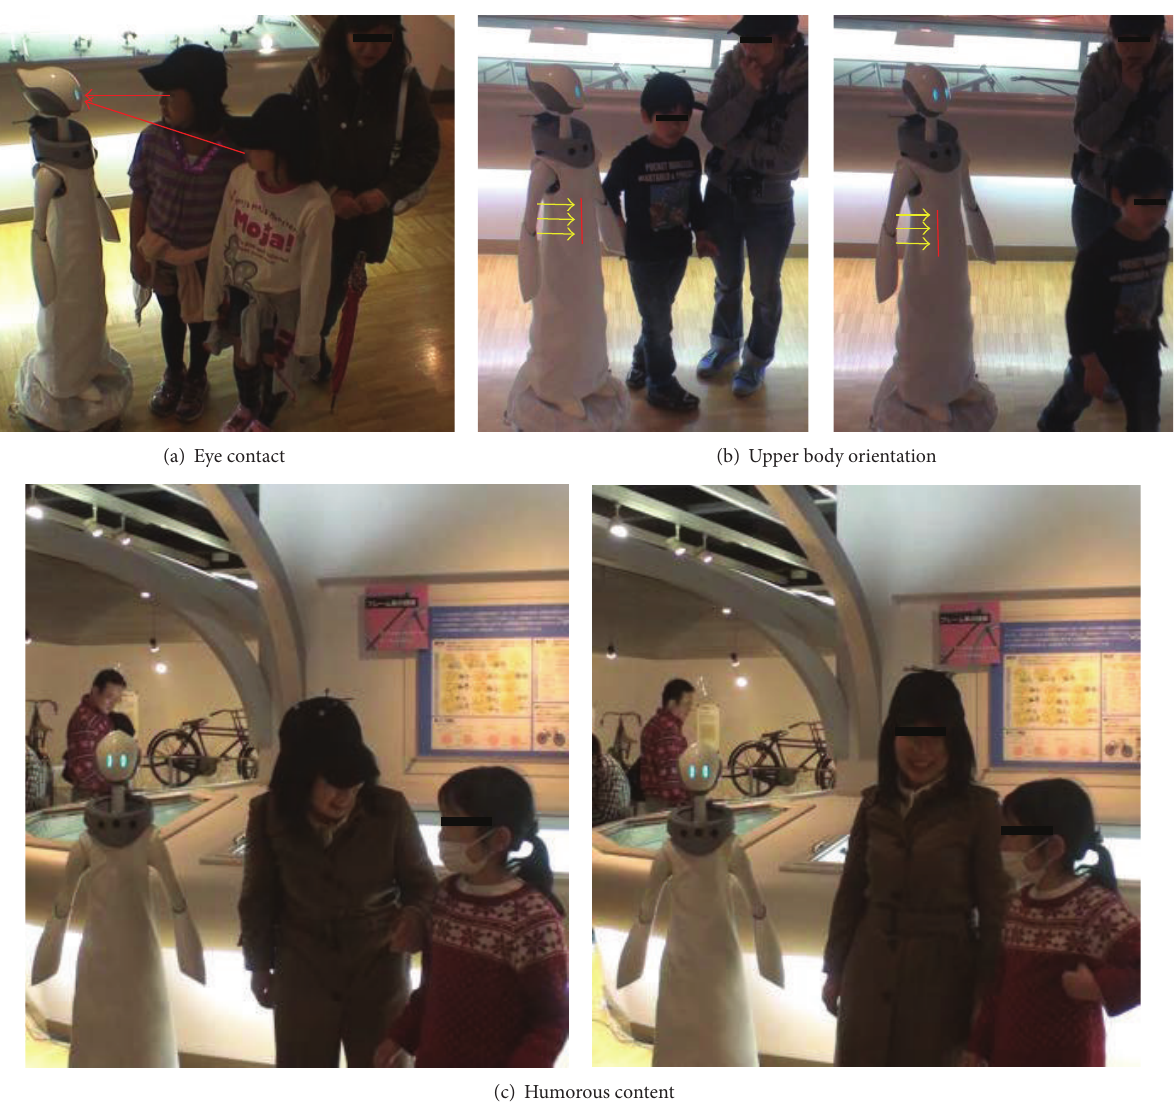
Figure 8: The subjects’ reactions to the engagement